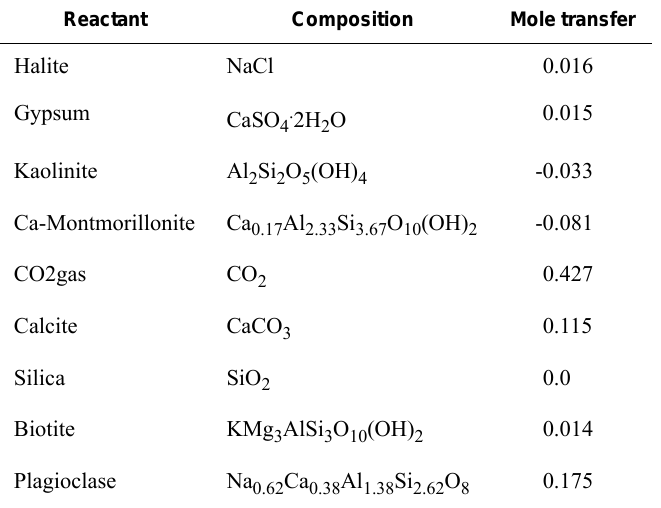
Table 46. Reactant compositions and mole transfers given by Garrels and Mackenzie (1967).